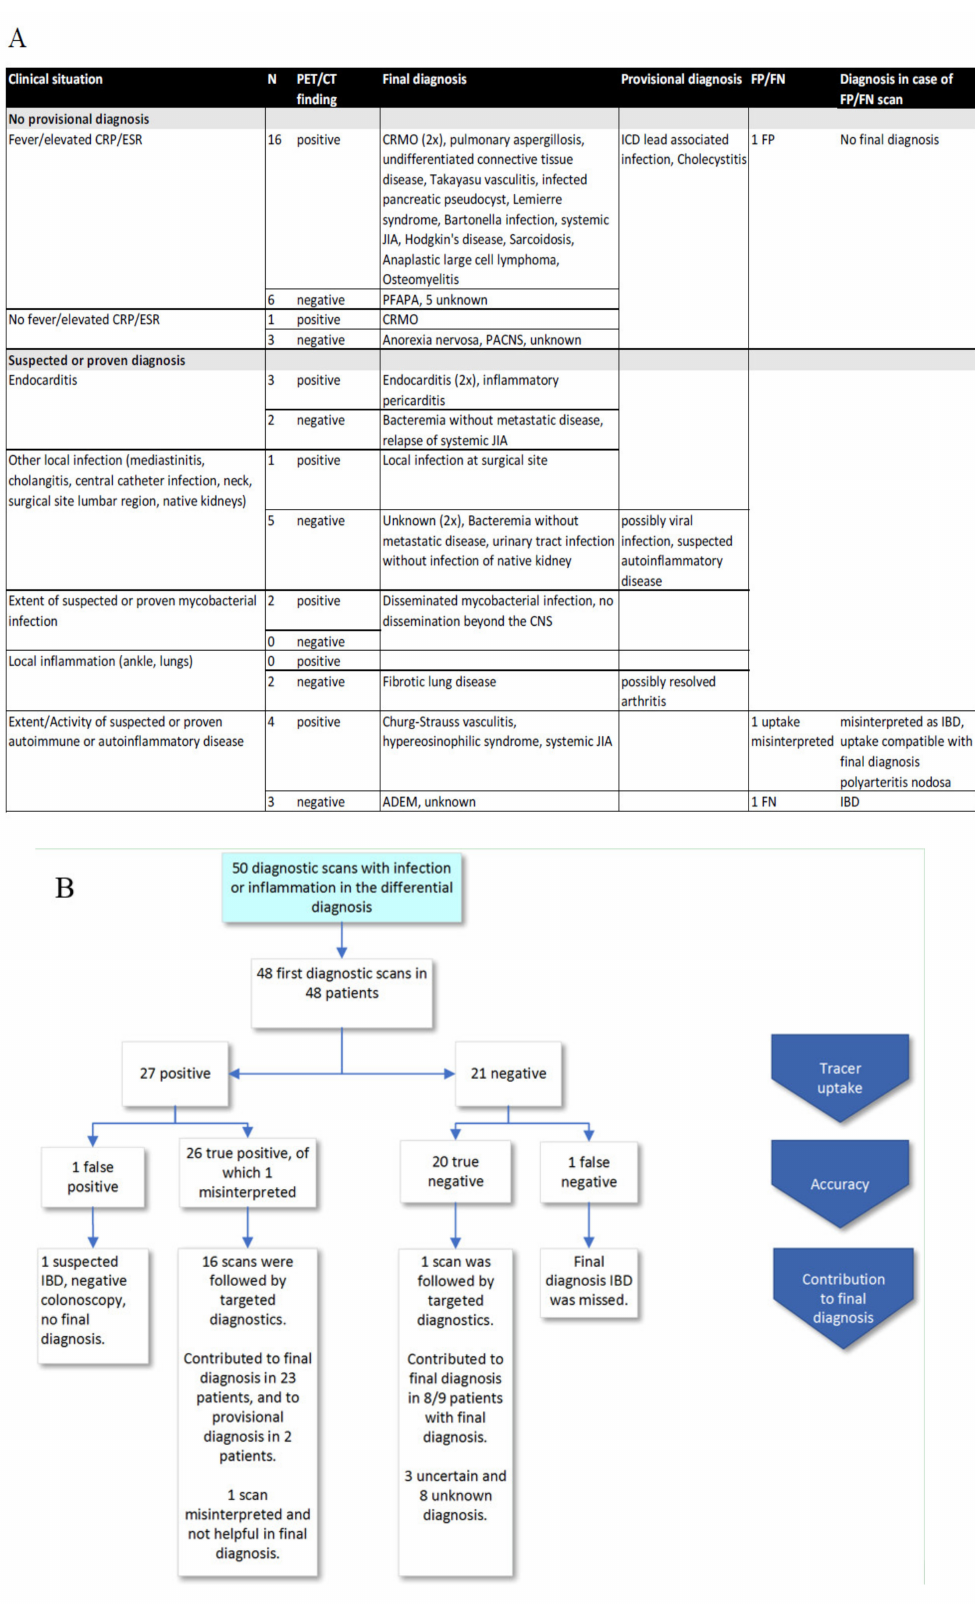
Figure 2. Scans performed for primary diagnosis (diagnostic scans). ( A ) Clinical situation, FDG-PET / CT findings and final diagnosis, false positive and negative findings. ( B ) Scan results, targeted